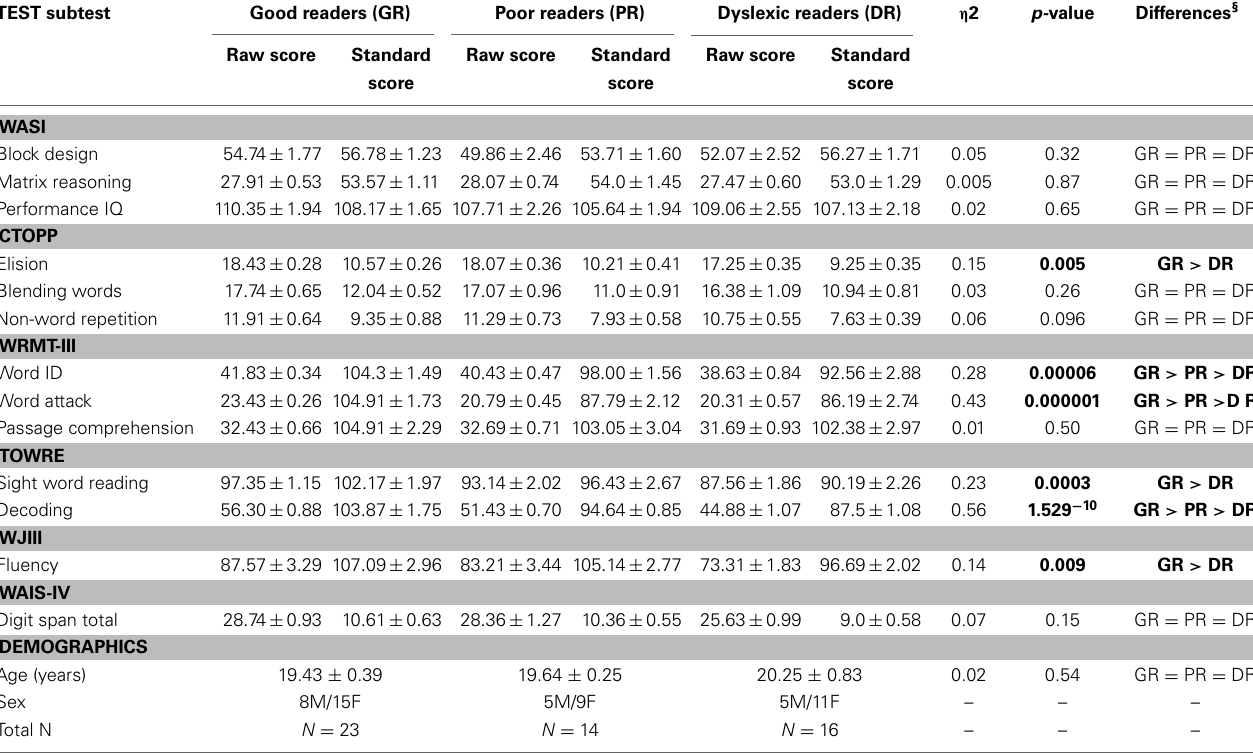
Table 2 | Participant behavioral assessment